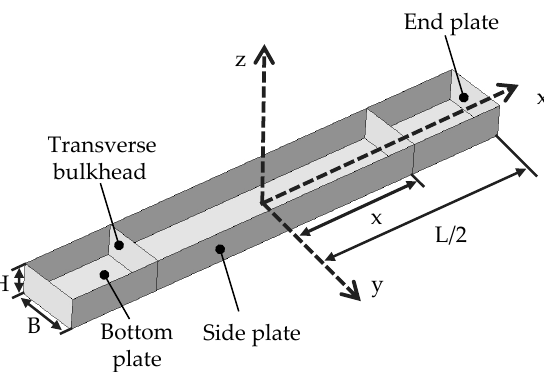
Figure 10. Schematic diagram of